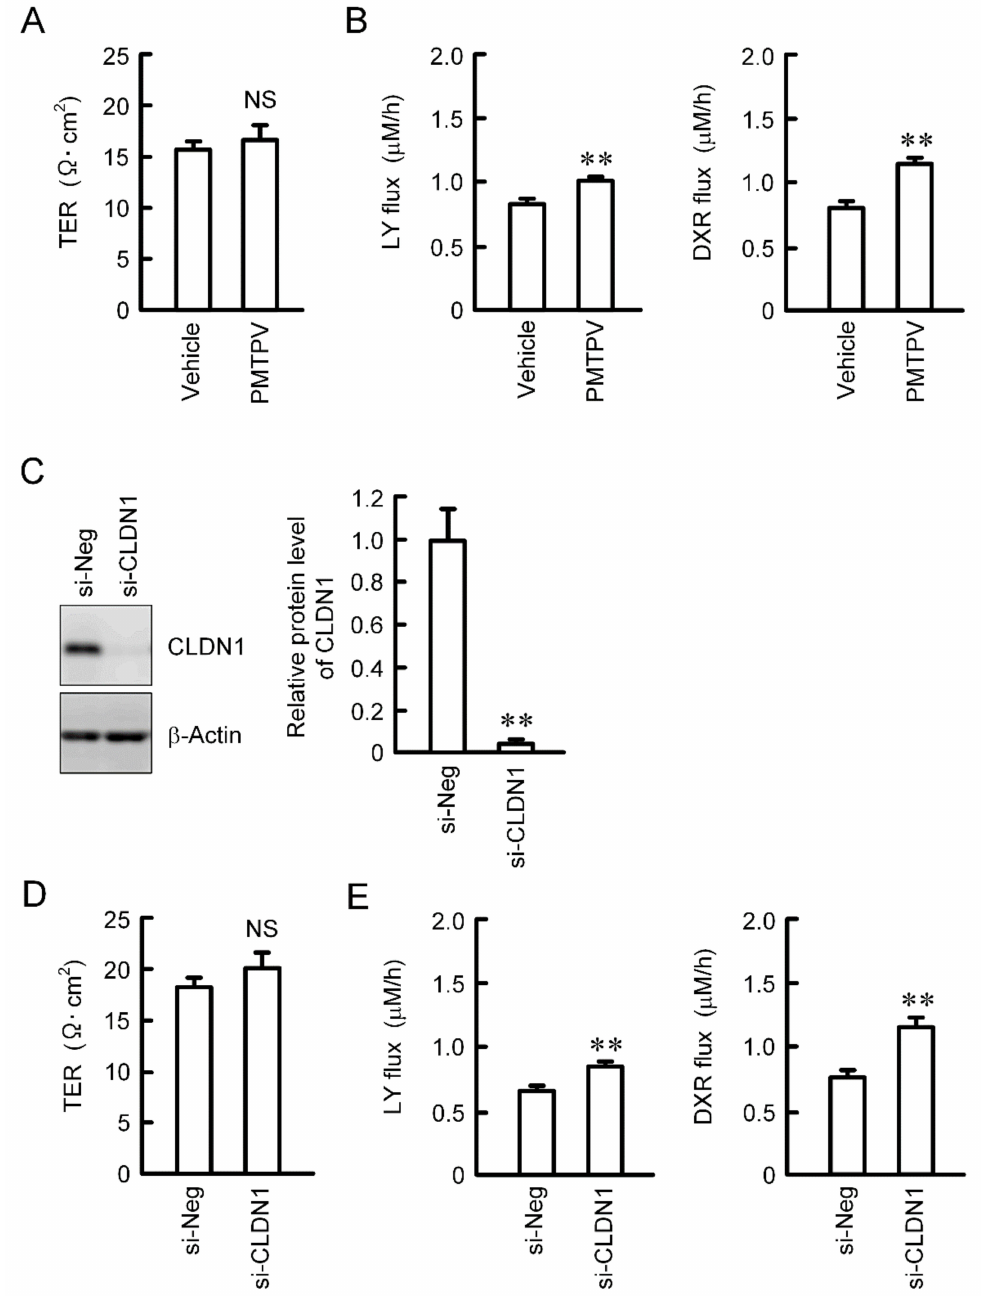
Figure 5. Increase in paracellular permeability of small molecules by PMTPV and CLDN1 siRNA. ( A , B ) A549 cells cultured on transwell plates were incubated in the presence and absence (vehicle) of 100 µ M PMTPV for 24 h. TER was measured using a volt ohmmeter. LY (10 µ M) or DXR (10 µ M) was added to the apical compartment. After incubation at 4 ◦ C for 1 h, the solution in the basal compartment was collected. The concentration of DXR and LY was measured using an Infinite F200 microplate reader. ( C – E ) A549 cells were transfected with negative (si-Neg) or CLDN1 siRNA (si-CLDN1). The protein level of CLDN1 was examined by Western blotting and represented relative to the values in the cells transfected with negative siRNA. Paracellular permeability was estimated by TER, LY flux, and DXR flux. n = 4–6. ** p < 0.01 compared with vehicle or si-Neg. NS, p >